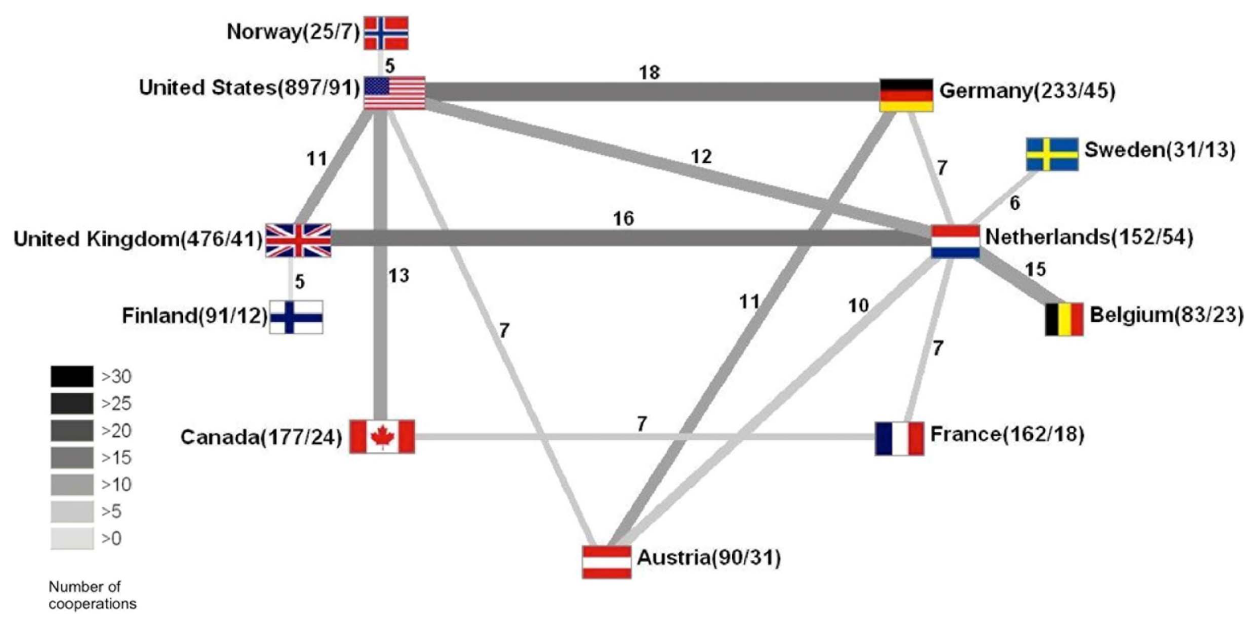
Figure 5. Global collaborations - Each country is represented by its flag, while the first number in brackets represents the total volume of national publications, the second one represents the number of cooperation articles of the specific country, the number above the beam represents the number of collaborative articles.